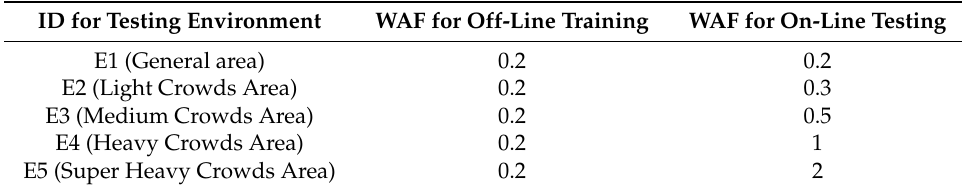
Table 5. Robustness testing for five different environments.